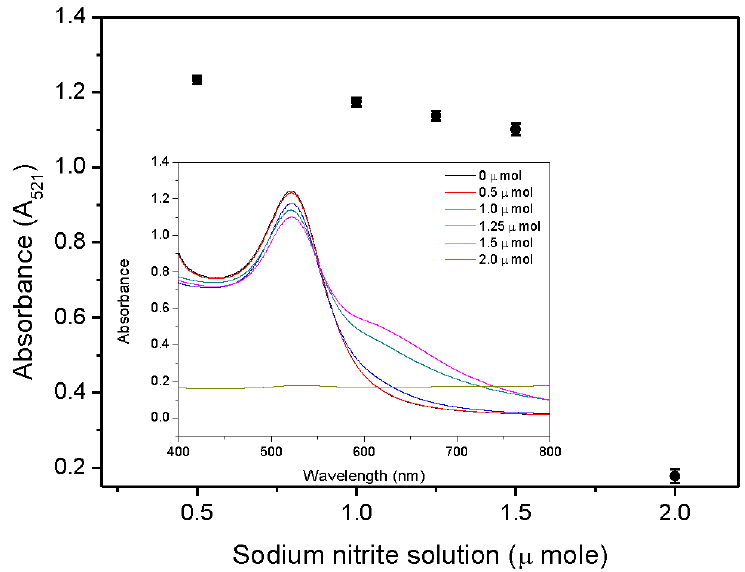
Figure 4. Absorbance at 521 nm of the blank test (without the existence of analyte) with different volumes of sodium nitrite solution. The inset shows the UV-vis spectra of functionalized AuNPs.